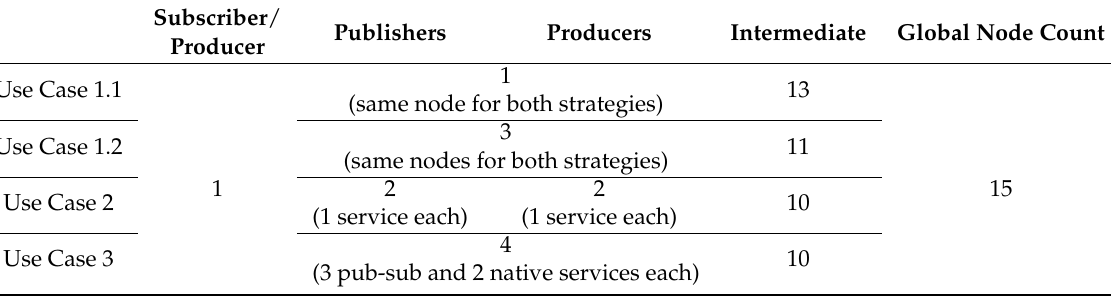
Table 2. Network topology—Node count per Use Case.